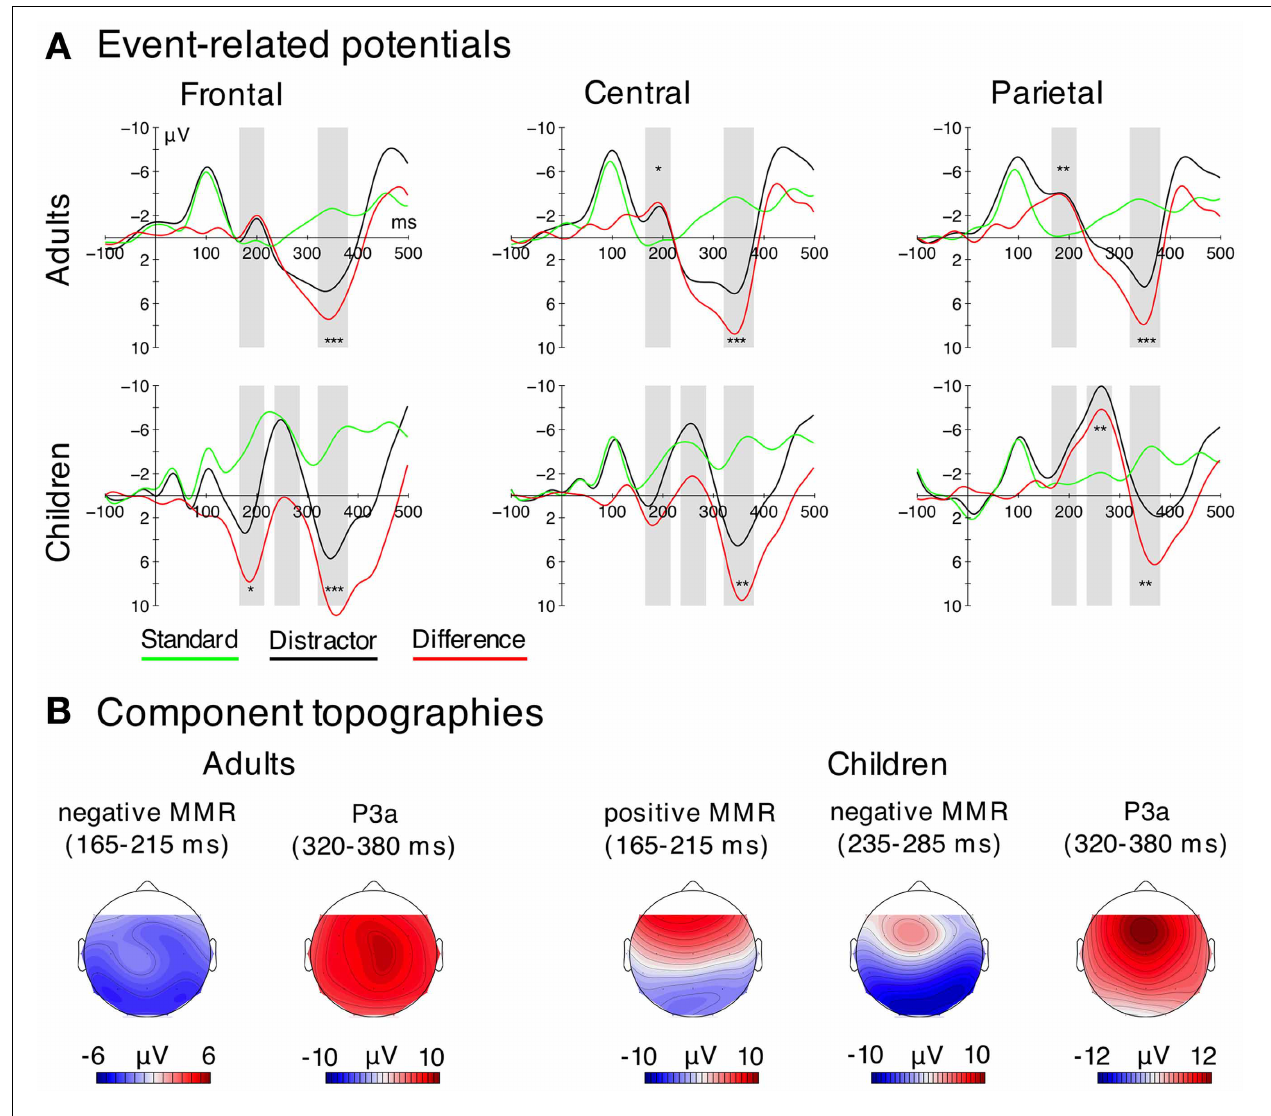
FIGURE 2 | EEG data. (A) Grand average ERPs for both stimulus types (distractor—black; standard—green) and difference waves (distractor-minus-standard—red) for three regions used for the statistical analysis (frontal = F3, Fz, F4; central = C3, Cz, C4; parietal = P3, Pz, P4). Negativity is plotted upwards. Time windows used for the statistical analysis